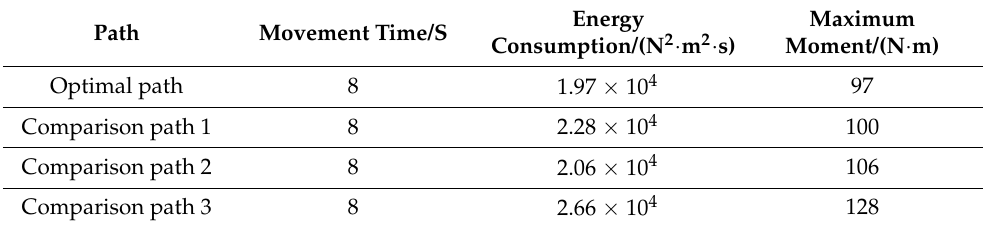
Table 2. Comparison of the energy consumption levels of the different climbing paths on a straight rod.